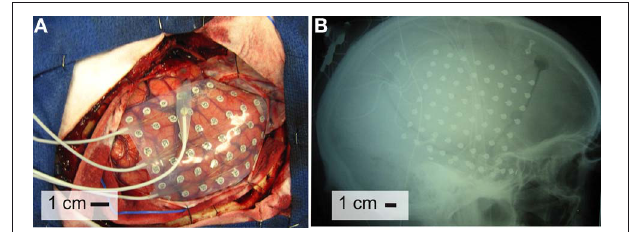
FIGURE 1 | (A) Exemplar electrode array on the surface of the brain. (B) Electrodes as seen on a lateral skull